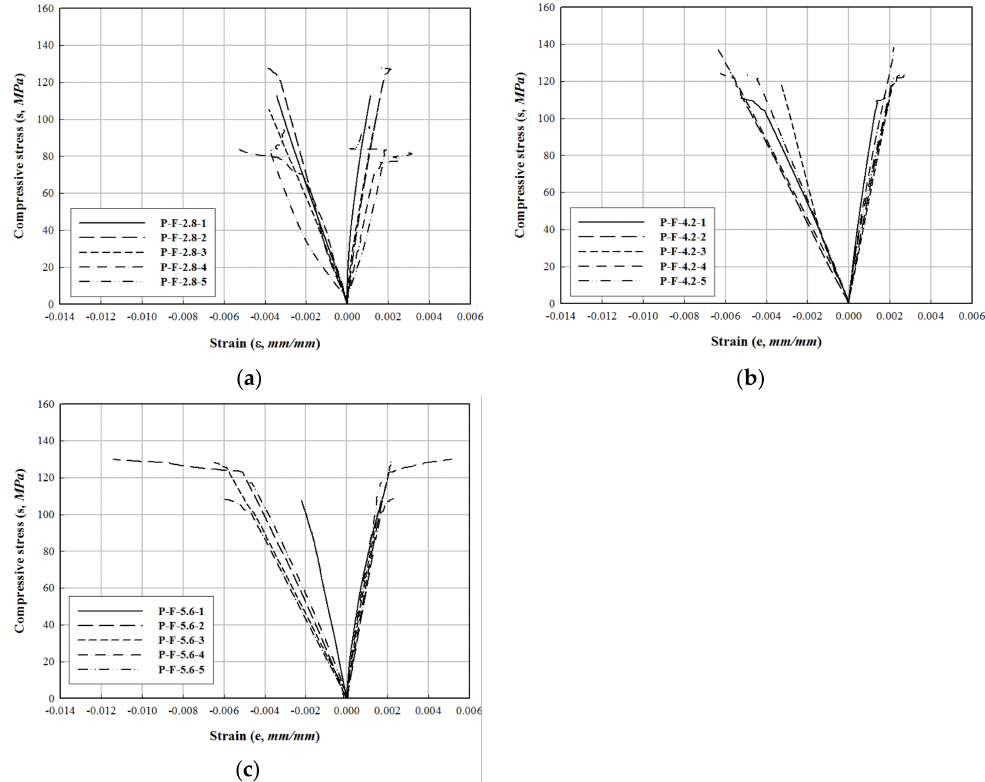
Figure 11. Stress–strain relationship of PFRP − FFRP. ( a ) P − F − 2.8. ( b ) P − F − 4.2. ( c ) P − F −